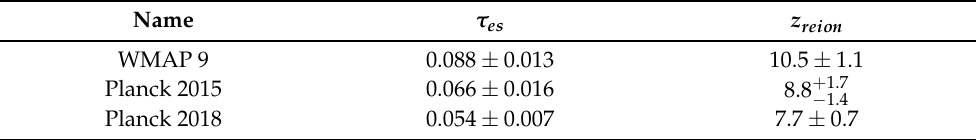
Table 2. Electron scattering optical depth and instantaneous redshift of Reionization, measured by WMAP and